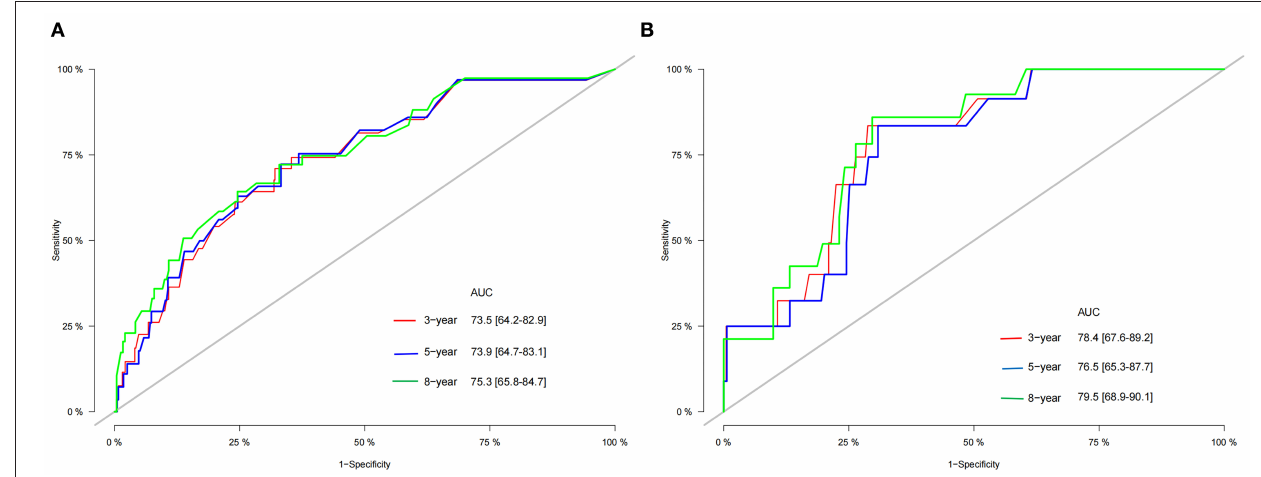
FIGURE 4 | The AUC of 3-, 5-, and 8-year in the training cohort (A) and validation cohort (B) .